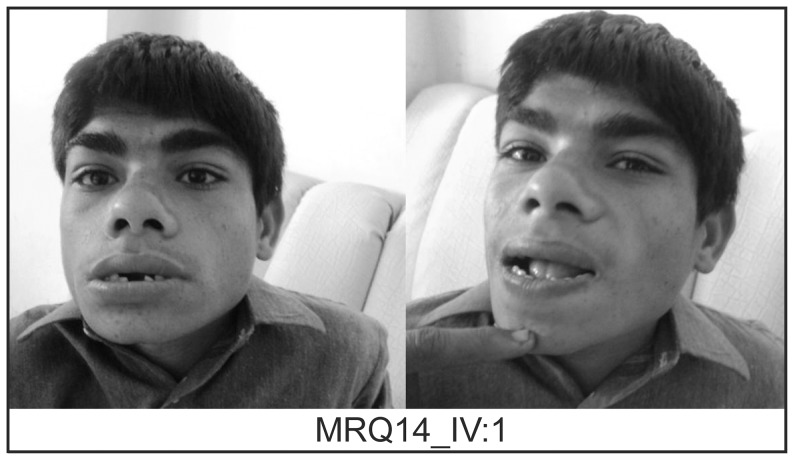
Photographs of MRQ14 proband.The photographs demonstrate the classic facial features representative of Kleefstra syndrome.